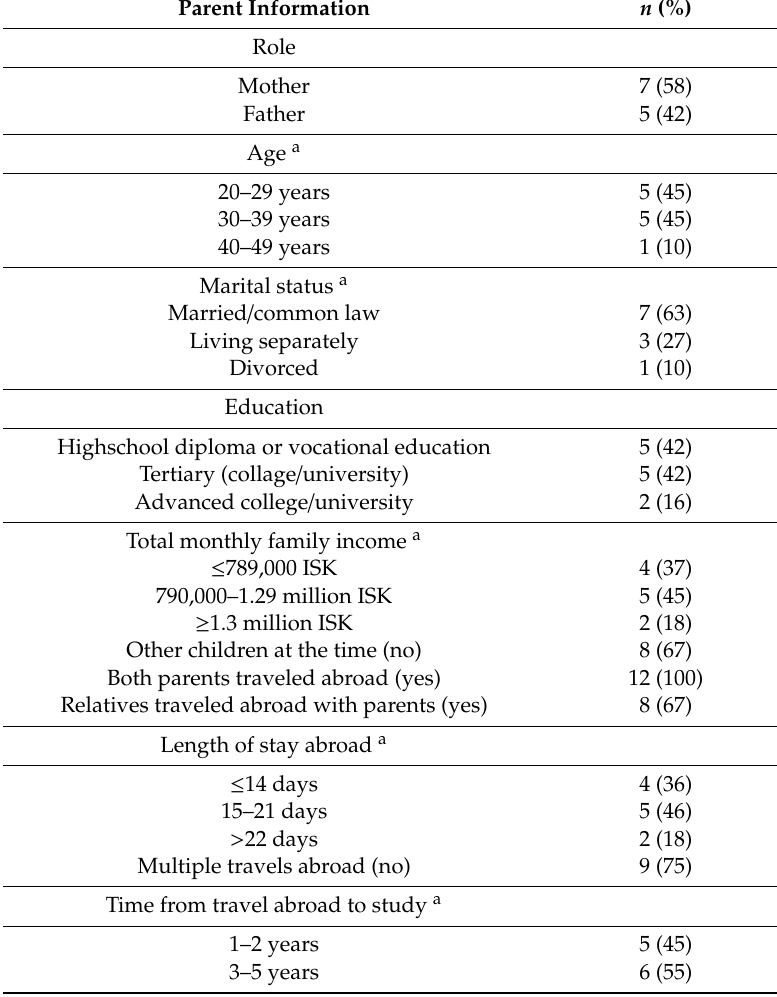
Table 1. Family demographics and background ( n =